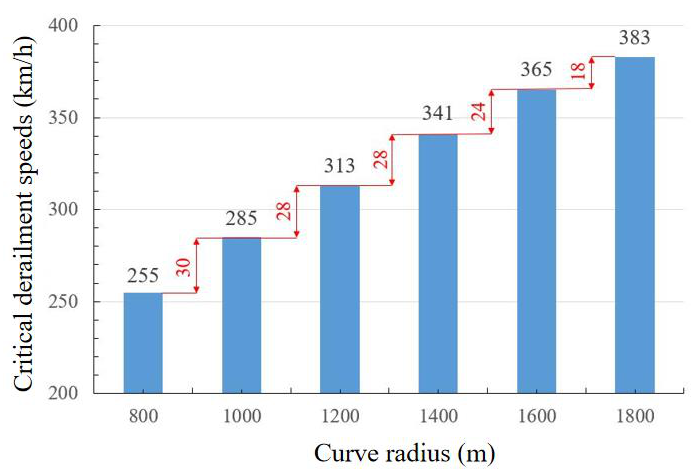
Figure 5. The critical derailment speeds under different radius curves.